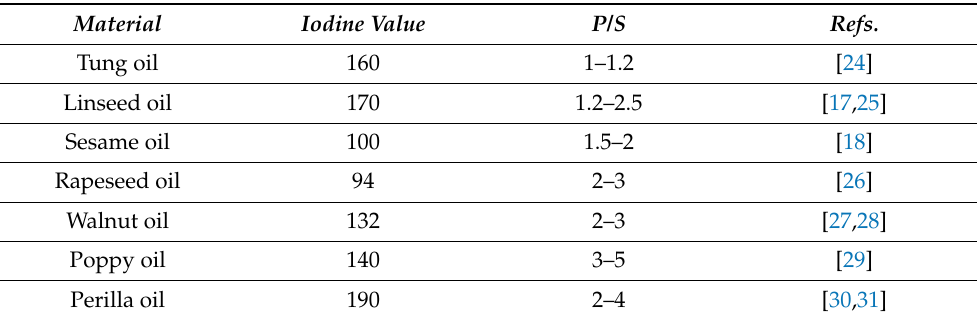
Table 1. Oils found in the Asian region. The iodine values were adapted from a collaborative study and indicates the measure of the relative degree of unsaturation in oil components [23]. Drying oil > 130. Palmitic/Stearic (P/S) data from various sources are cited.